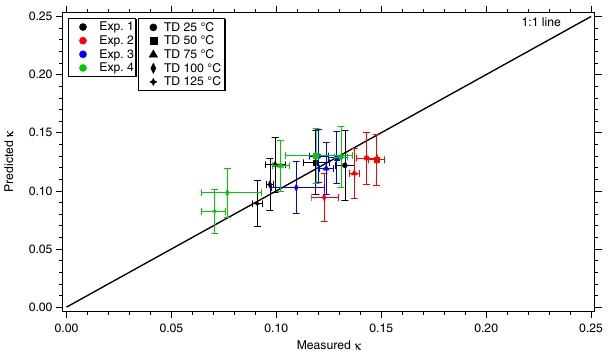
Figure 8. The predicted versus measured O:C ratios for all TD temperatures in all of the experiments. The color indicates the ex- periment number, and the symbol indicates the TD temperature. The error bars for the predicted O:C ratios were obtained by predicting the O:C ratios using the O:C ratio distribution at ± 1 standard deviation in Fig. 7a.